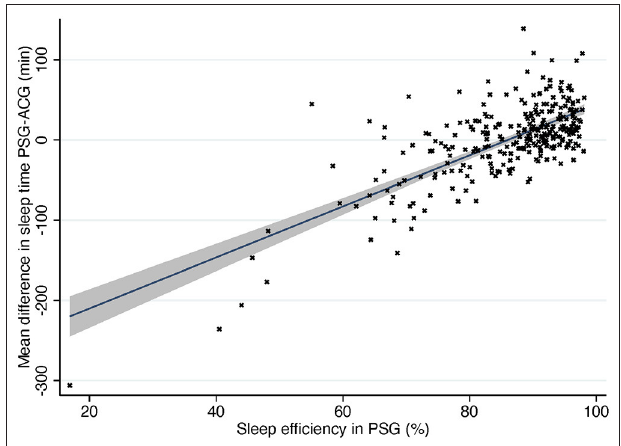
FIGURE 4 | Difference in sleep time compared to sleep efficiency in PSG. Solid line, mean difference. Gray area, 95% confidence interval for regression line. PSG, polysomnography; ACG,